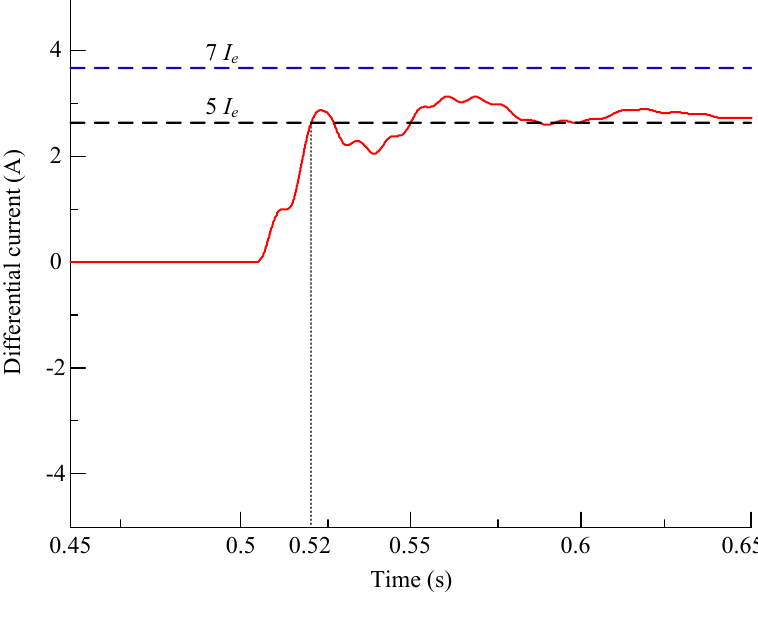
Figure 14. Differential current and different setting values of the over-current